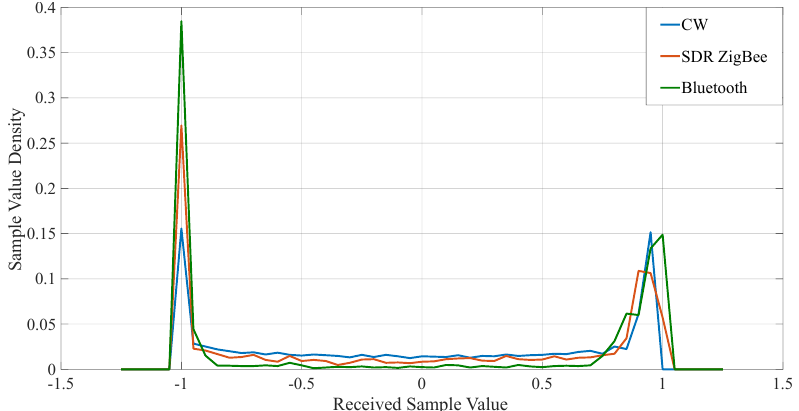
Figure 6. Example PDFs for receiver saturation, emphasizing how PDF become difficult to distinguish and the need for features not dependent on the